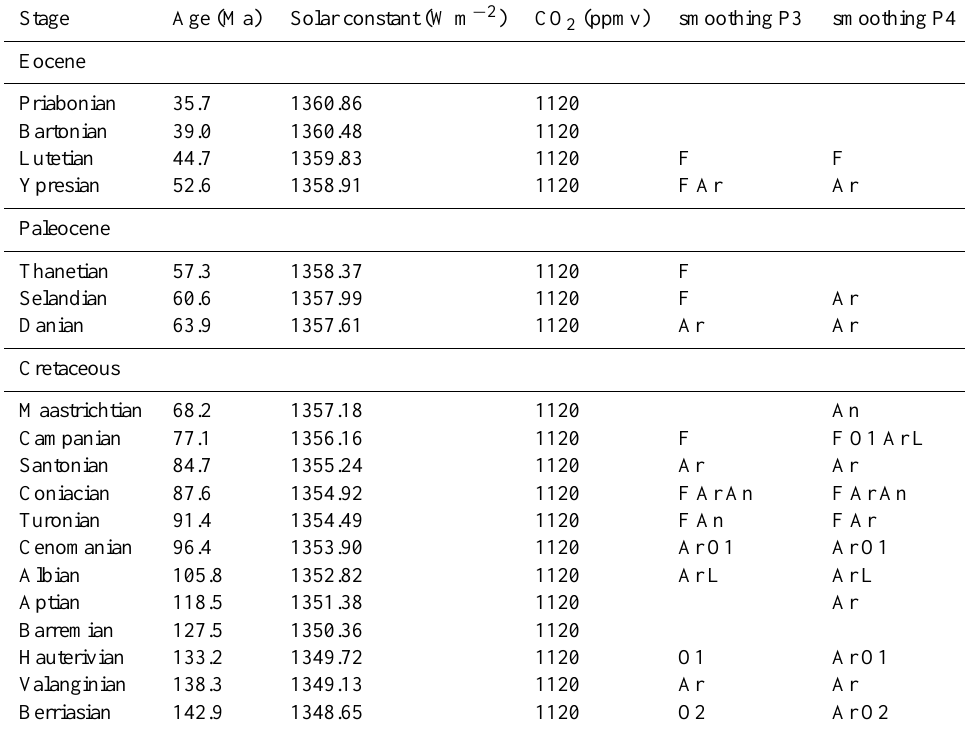
Table 1. Summary of all model simulations. The age column shows the age of the middle of the respective Stage. The solar constants are calculated using these ages according to the formula described in Gough (1981). The smoothing indicates the changes that had to applied to each Stage to ensure stability. F = fourier filtering at high latitudes, Ar = flat Arctic ocean, An = flat polar Southern ocean, O1 = polar orographic smoothing, O2 = polar orographic smoothing and capping of polar topography, L = minor changes to land–sea mask. P3 and P4 indicate Phases 3 and 4 of the